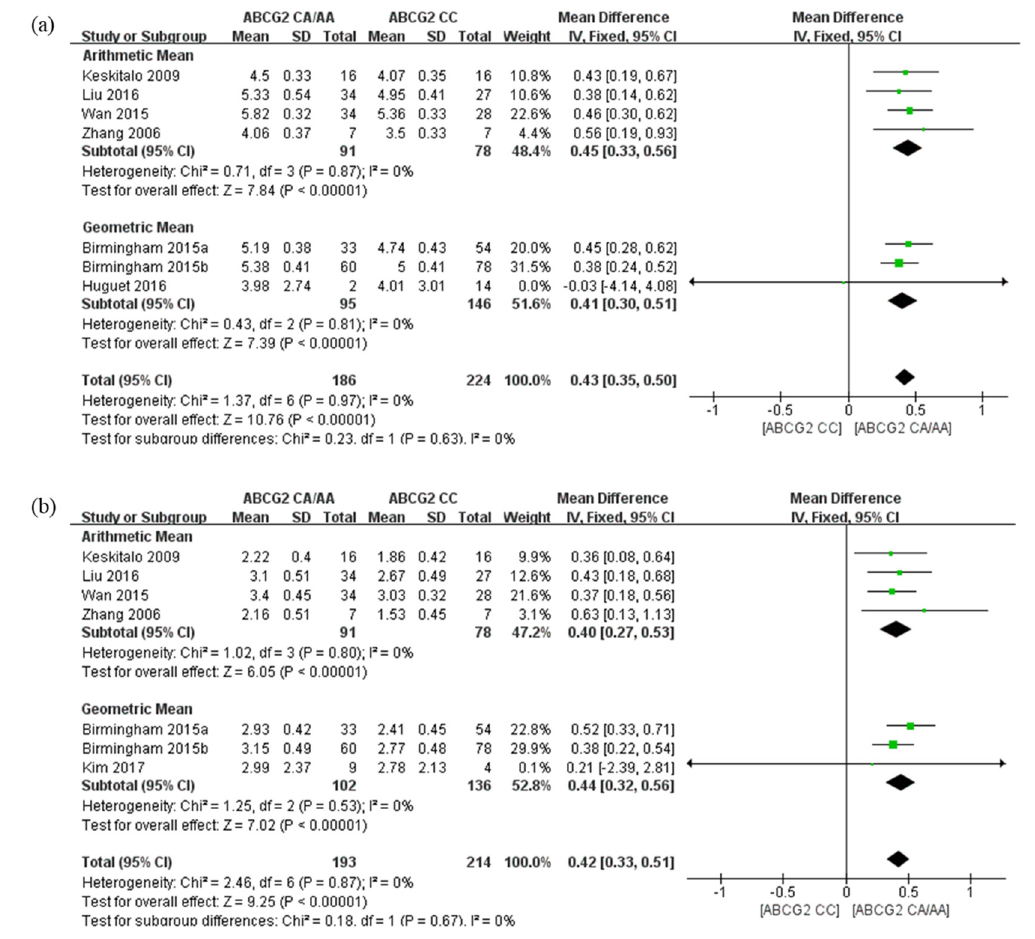
Figure 4. Forest plots of the effects of ABCG2 421C>A on rosuvastatin; values expressed as logarithm of geometric mean ( a ) AUC 0- ∞ and ( b ) C max with measured values of studies given as geometric means and arithmetic means. The effect size for each individual study is represented by the green square and the overall pooled effect size is represented by the black diamond.